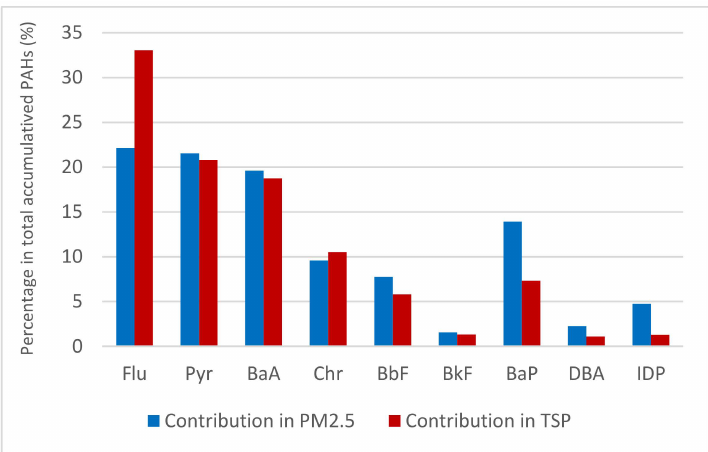
Figure 4. Contribution percentage 1 of individual PAH in PM 2.5 and TSP. The percentage of each PAH in total accumulated PAH in Figure 4 were calculated as the di ff erence between the content of PAH adsorbed on PM in BB samples (mg g − 1 ) and the content of corresponding PAH on PM in BG samples.